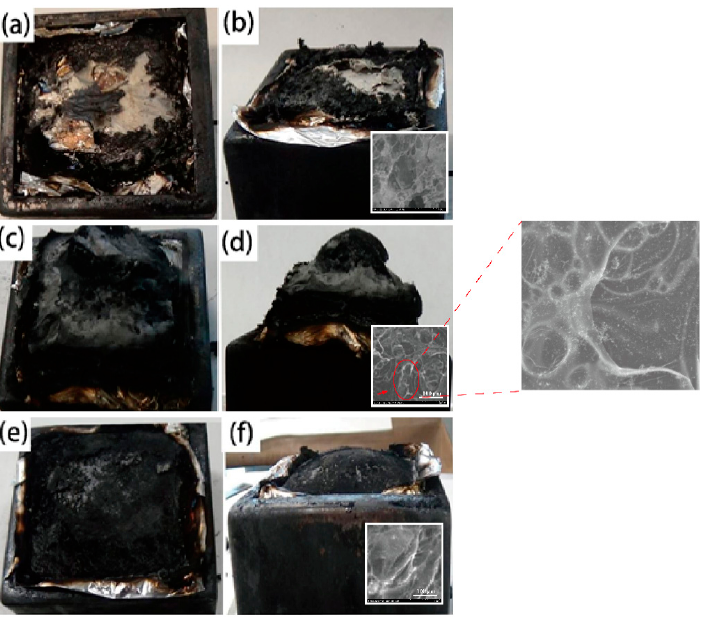
Figure 7. The digital photographs of residue after cone calorimeter test: ( a , b ) EP; ( c , d ) EP/AP750; ( e , f )